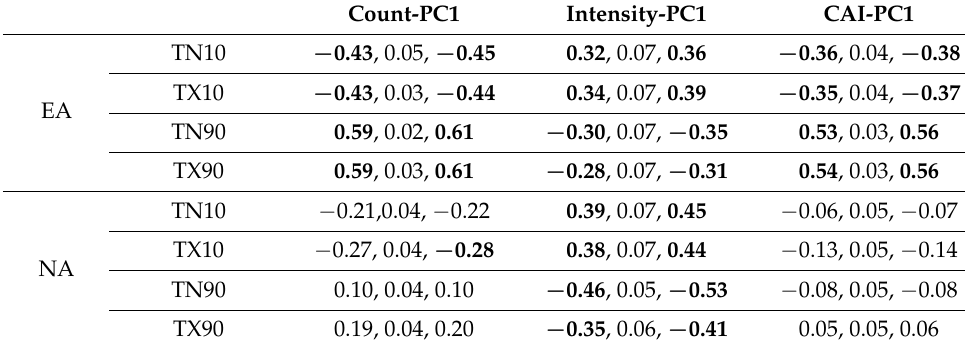
Figure 8. Correlations between the principal component of JFM extreme temperature anomalies and the JFM cyclone activity indices over Eurasia ( top ) and North America ( bottom ). Correlations are calculated using linearly de-trended time series over the period 1951 – 2010. Green, blue, yellow, and red curves indicate cyclone activity correlating with the principal components of TN10, TX10, TN90, and TX90 anomalies, respectively. Results for the cyclone count, intensity and index are presented from left to right. The horizontal axis is the member number. Members 1 – 80 indicate individual members, member 81 indicates the average correlations from the 80 members, and member 82 indicates the correlation calculated from the ensemble mean indices. The dashed line indicates the correlation that is statistically significant at the 5% level. Table 3. Statistics related to correlation coefficients in JFM between the linearly de-trended cyclone index and the PC1 of extreme temperature anomalies over Eurasia and North America for the period from 1951 to 2010. Three numbers over each region, in turn, indicate the average and standard deviation of the 80 correlations calculated from the ensemble members and the correlation calculated from the ensemble average indices. The effective sample size is found to be at least 49 for the 60 seasonal time series in these calculations. The 5% significance level of a correlation is r > 0.28 for 49 degrees of freedom. The number in bold indicates a correlation significant at the 5% level.